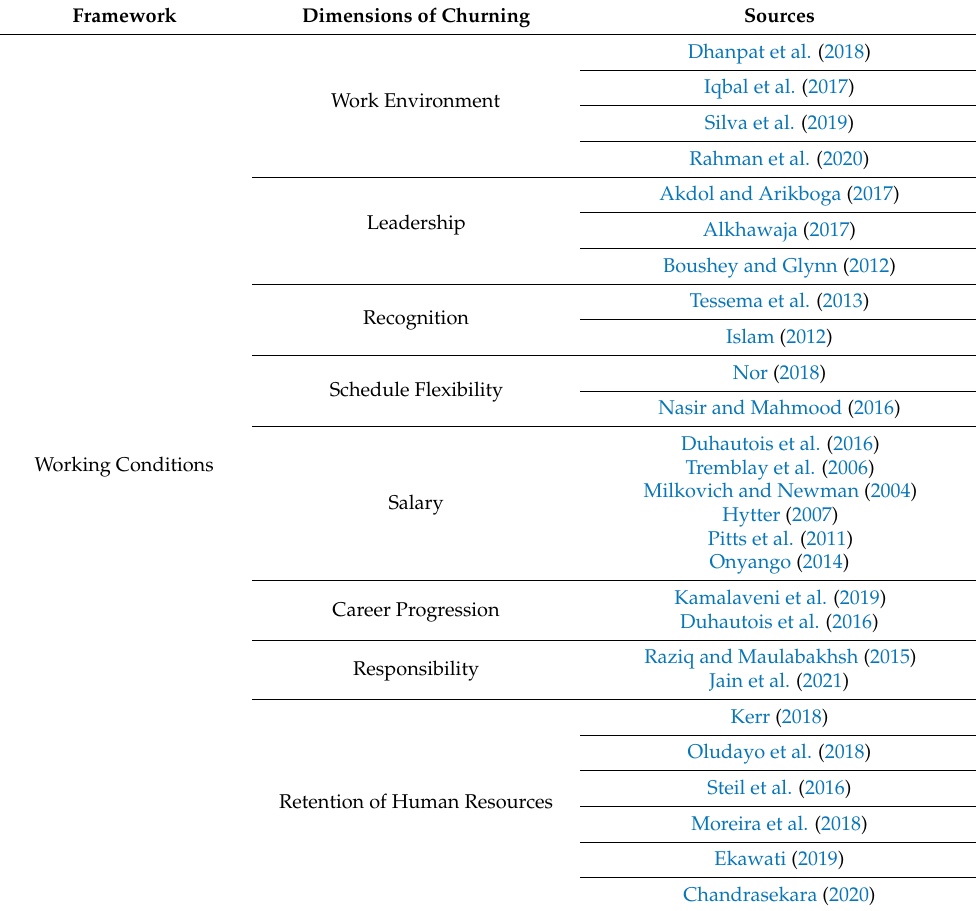
Table 2. Selected dimensions of churning based on empirical studies published between 2004 and